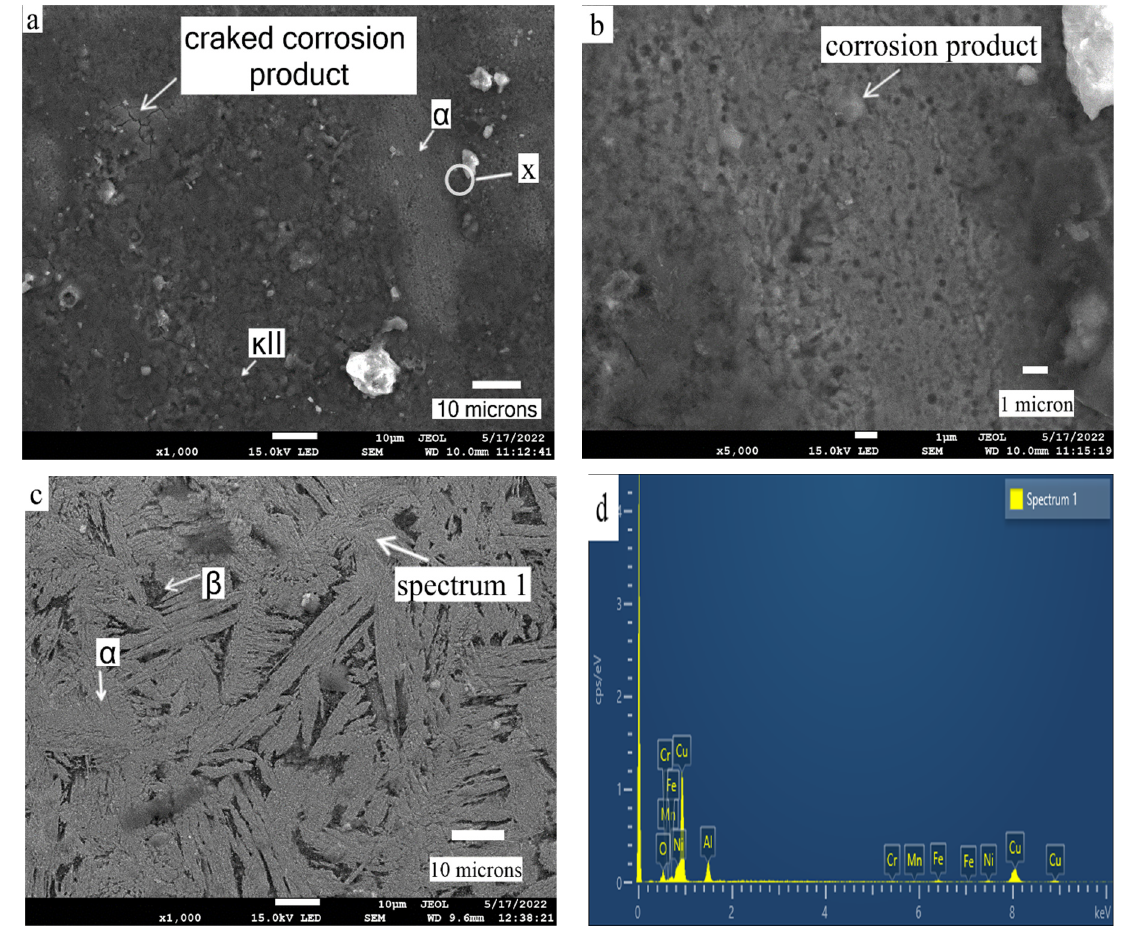
Figure 13. Scanning electron microscope morphology of slurry erosion–corrosion for ( a ) as-cast NAB at 30° (1000×), ( b ) magnified image at X (5000×), and for ( c ) FSPed composite at 30° (1000×), ( d ) EDS image of spectrum 1.